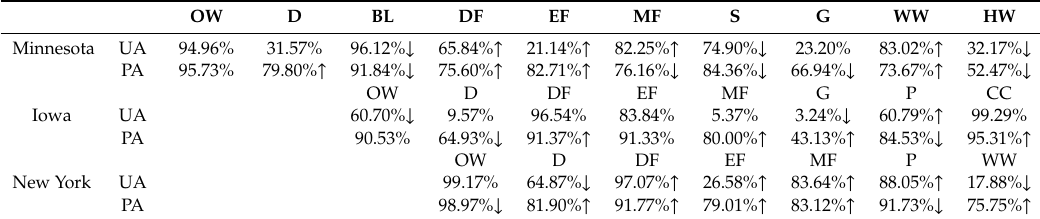
Table 5. Average producer and user accuracies of the classifications derived from TSM-adjusted percentiles (see Table 3 for the associated overall accuracies). Ten independent classification experiments in total were carried out. Note that the upward (downward) arrows indicate that the accuracies obtained using the TSM-adjusted percentiles are significantly (at the 5% level) higher (lower) than that obtained using the original percentiles. Figure without arrow behind it represents that there is no significant di ff erence between the two sets of